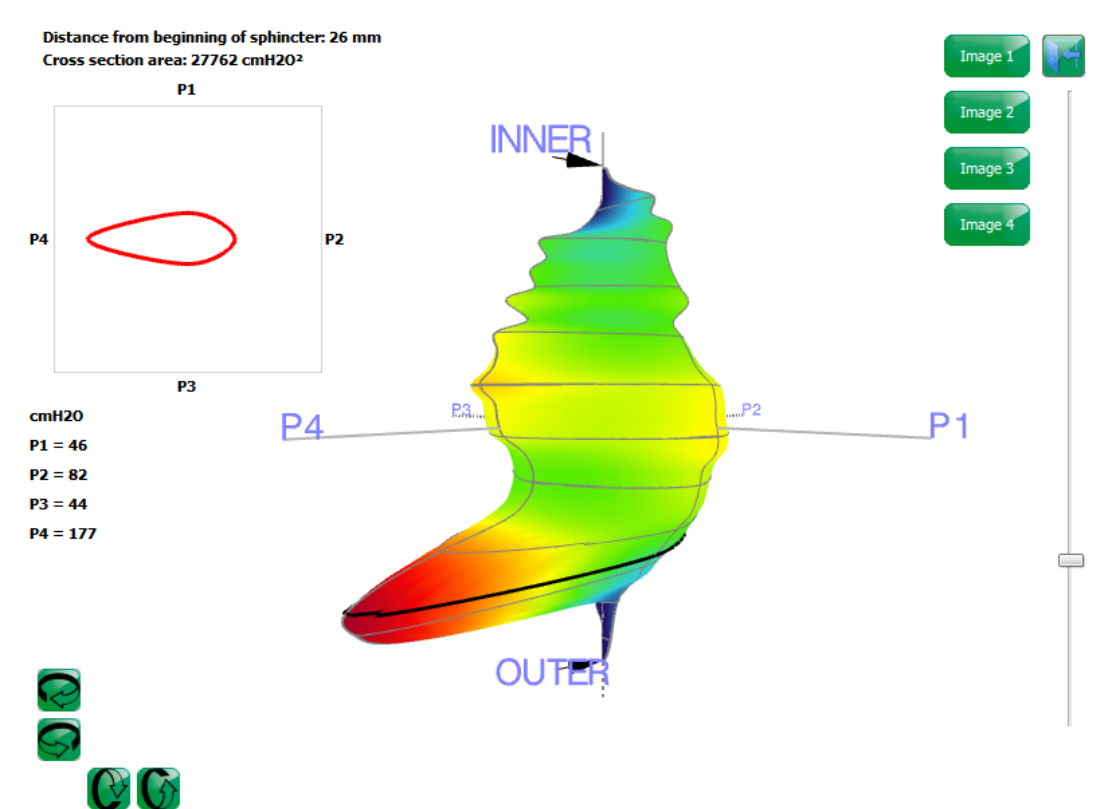
Figure 3. Cross section of the vector volume in correspondence with the distance from the beginning of the sphincter.